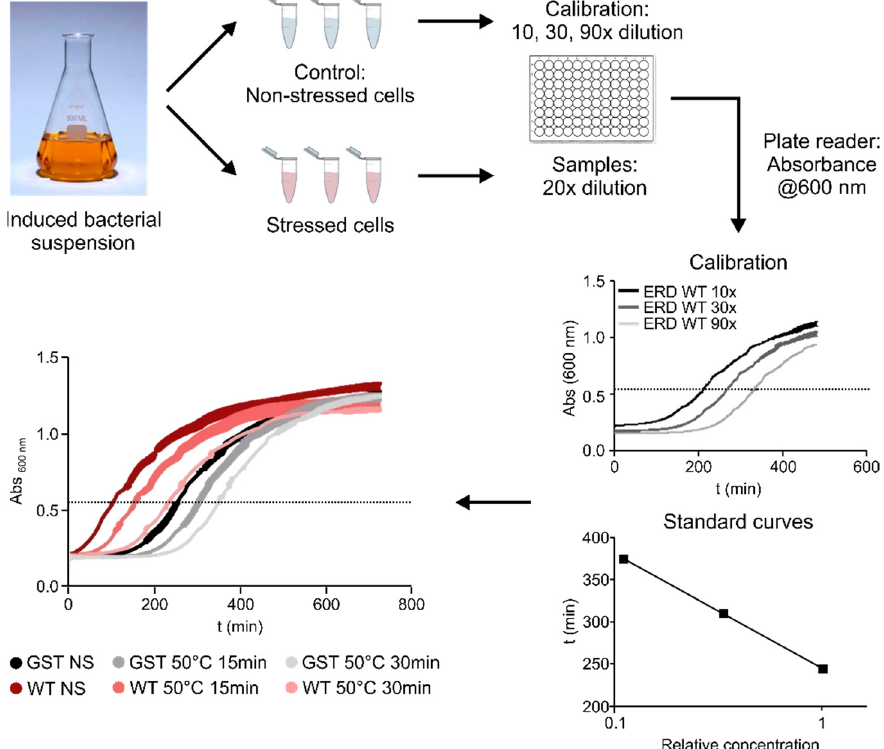
Figure 2. Overview of the viability assay. After a standard induction period, cells were stressed by a heat shock of 50 °C for 15 min (final set-up, after optimization of the stress conditions by screening at different temperatures for different time length shown at the left bottom panel). Viability of stressed and non-stressed samples were compared based on their cell growth after appropriate dilution in fresh medium (Calibration—grey curves). Cell growth was followed by absorbance at 600 nm. Half-time of growth curves varies linearly, with dilution plotted on a logarithmic scale, i.e., it is informative of the concentration of viable cells in the sample. For our experiments, we have set the OD at 0.6 as this period of growth by convention and applied serial dilutions to obtain the calibration curve and calculate the relative survival ratios of the different samples (NS: non-stressed samples, S: stressed samples). Based on this, we can compare the viability of cells exposed to the same stress conditions but expressing various constructs (colored curves).